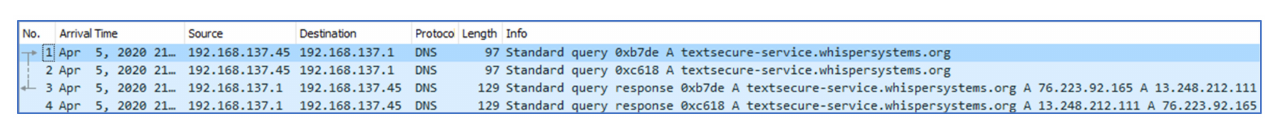
Figure 22. Signal DNS queries and